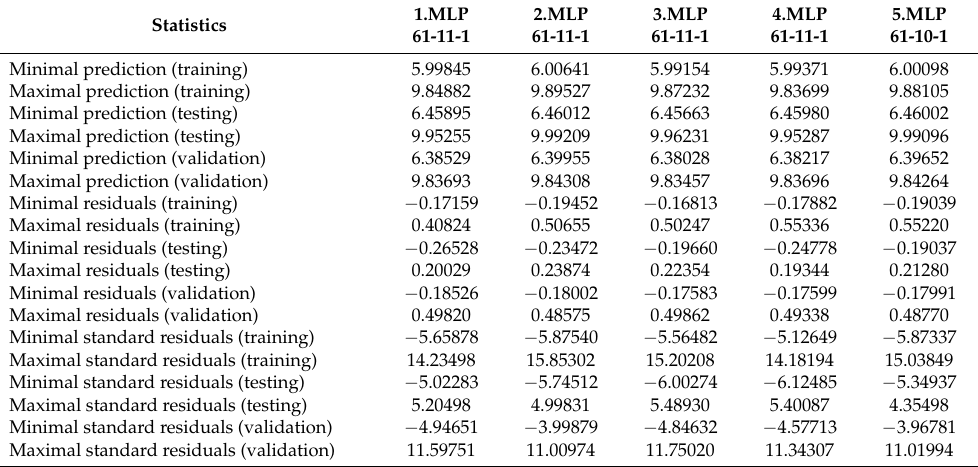
Table 6. Statistical characteristics of individual datasets according to the retained neural